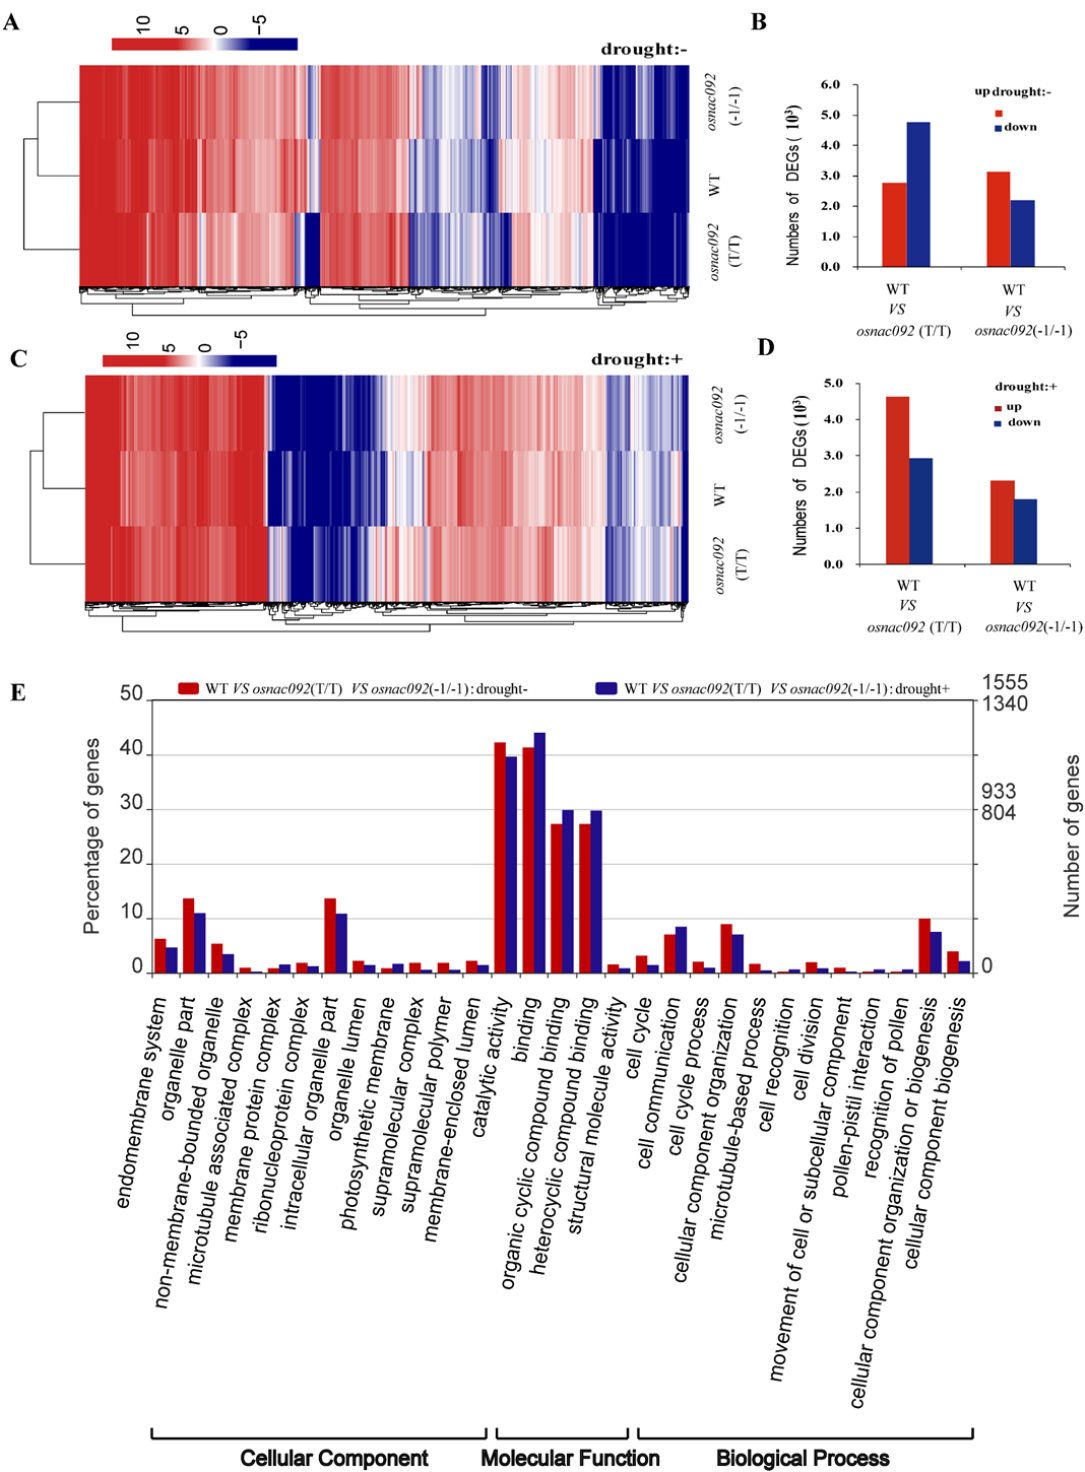
Figure 4. Knock out of OsNAC092 results in genome-wide changes in plants. ( A ). WT and osnac092 genome-wide expression analysis (drought − ). ( C ). WT and osnac092 genome-wide expression analysis (drought+). ( B , D ). Number of differentially expressed genes (DEGs) of WT and osnac092 . ( E ). Gene ontology (GO) classification of DEGs shared by WT vs osnac092 ( T/T) vs osnac092 (−1/−1):drought - and WT vs osnac092 ( T/T ) vs osnac092 ( −1/−1):drought+. Venn diagram analysis showed the results of the analysis of the DEGs of the two mutants compared with the WT plants. There were 3111 DEGs under normal conditions